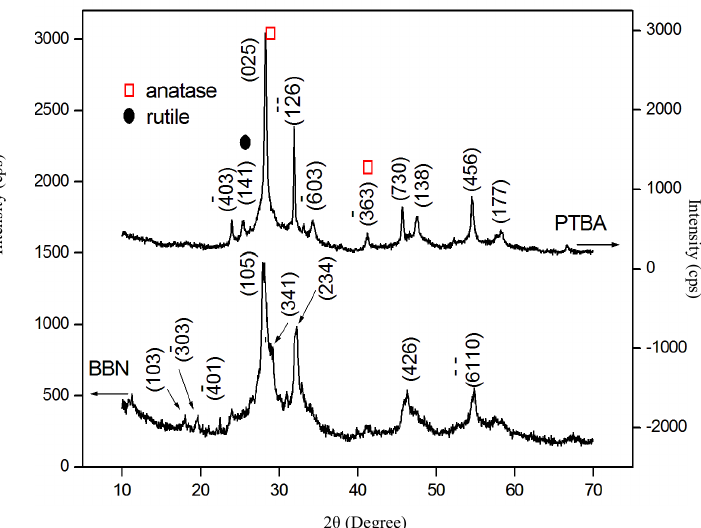
Figure 1. XRD patterns for bismuth basic nitrate, BBN and TiO Fourier transformed infrared spectroscopy